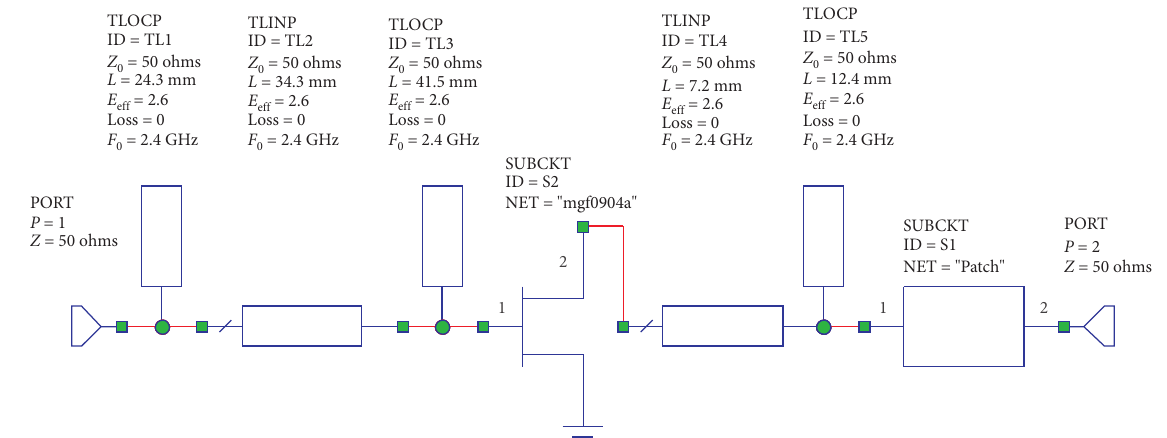
Figure 8: A two-port network model of the active transmitting antenna ATA.